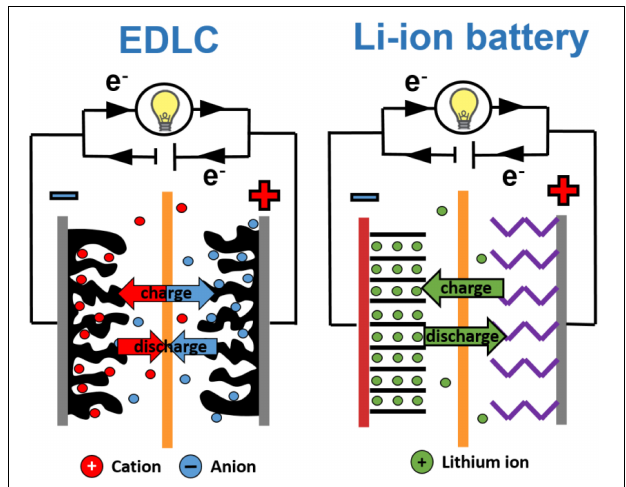
FIGURE 2 | Electrochemical capacitor and lithium-ion cell construction. Adapted from Béguin and Fra¸ckowiak (2009) and Béguin and Fra¸ckowiak (2013) with permission from Wiley-VCH Verlag GmbH & Co.